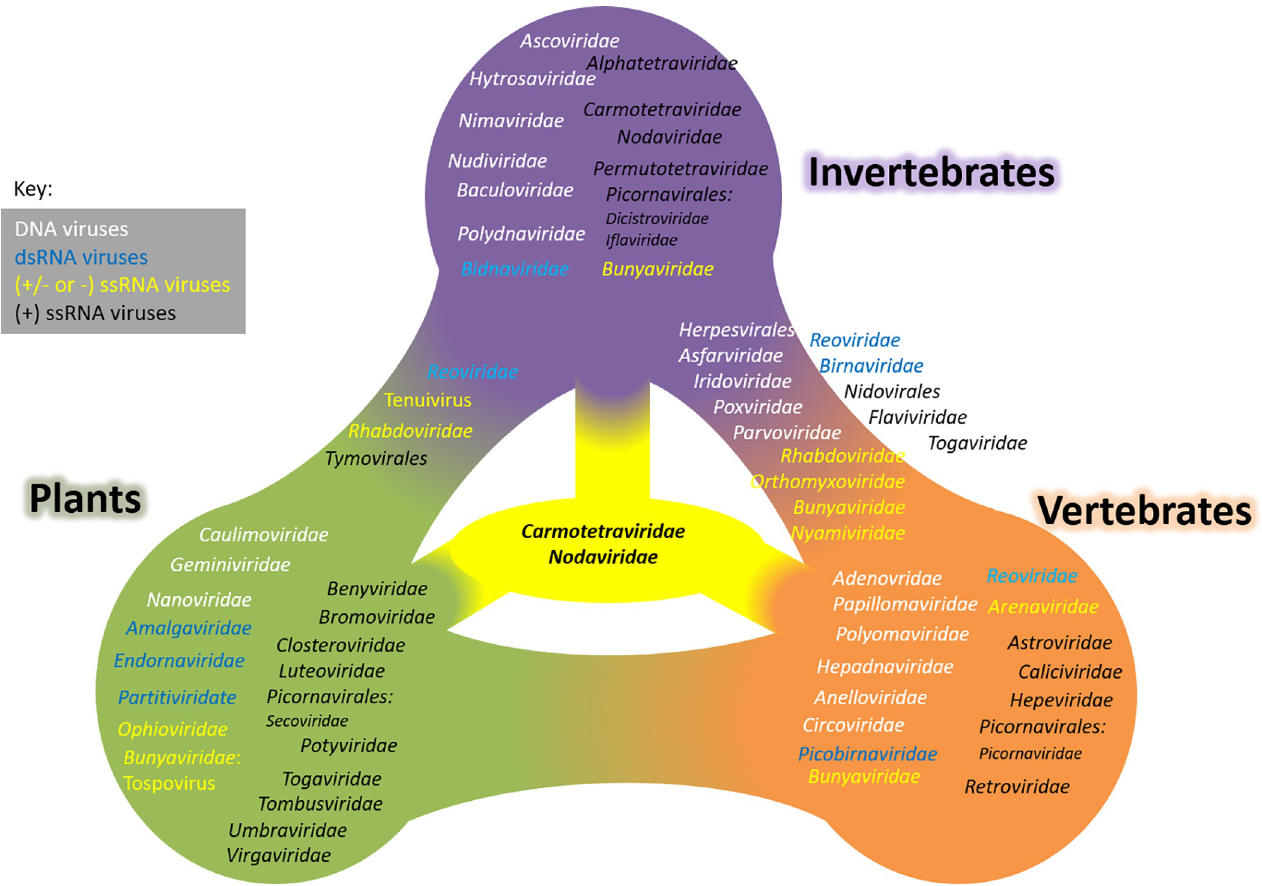
Fig 5. Diagrammatic representation of the host range of viruses. Invertebrate, plant and vertebrate-infecting virus families are shown in purple, green and orange respectively. The viruses infecting more than one type of host are positioned between the hosts. The Nodaviridae and the Carmotetraviridae , the only virus families that replicate in more than two types of host are shown in yellow in the centre of the figure. This figure is derived from the ICTV Master Species List version 1.1 updated April 6, 2017.